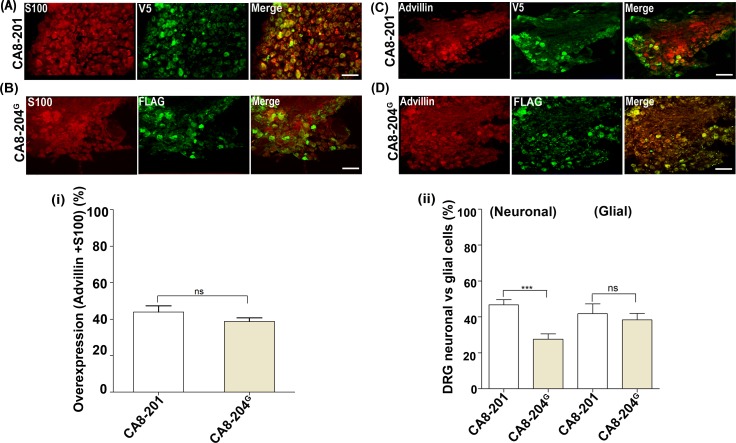
CA8-204G is expressed in DRG neuroglia and neuronal cell population.Immunostaining was performed in DRG sections in mice receiving SN of AAV8-V5-CA8-201MT, AAV8-V5-CA8-201 and AAV8-FLAG-CA8-204G. (A) Immunostaining was done using antibodies anti-V5 for CA8-201 (V5, green) and anti-S100 (glial marker) (S100, red), and anti-V5 with anti-S100 antibodies, respectively from the merged image (Merge). (B) Immunostaining was performed using antibodies anti-S100 (S100, red), anti-FLAG for CA8-204G (FLAG, green) and anti-FLAG and anti-S100 from the merged figures (merge); (C) Immunostaining using antibodies anti-Advillin (Advillin, red), anti-V5 (V5-CA8-201, green) and anti-Advillin and anti-V5 (Merge) from the merged figures was carried out in DRG sections; (D) Using antibodies anti-Advillin (Advillin, red), anti-FLAG for CA8-204G (FLAG-CA8-204G, green) and anti-FLAG and anti-Advillin from the merged figures (merge). (i) Histogram of the IF results demonstrates CA8-201 and CA8-204G co-localize with DRG neuroglia and neuronal populations. The % overexpression was calculated from the positive cells overlapping with advillin and S100 markers, divided by DAPI as counter-stain which was used. (ii) Overlap (%) between CA8-204G and CA8-201 were calculated separately from the total population of DRG glial and neuronal cells. IF was done using DRG tissues retrieved from animals after 4 weeks after SN injection. Percentage of overexpression of CA8-201 and CA8-204G and overlap in total DRG cells were quantified using one-way ANOVA with Bonferroni's post-hoc test (***P<0.001, **P<0.01, *P<0.1, ns = non-significant, N = 8 each gene group). (IF = Immunofluorescence) (Scale = 50μm).